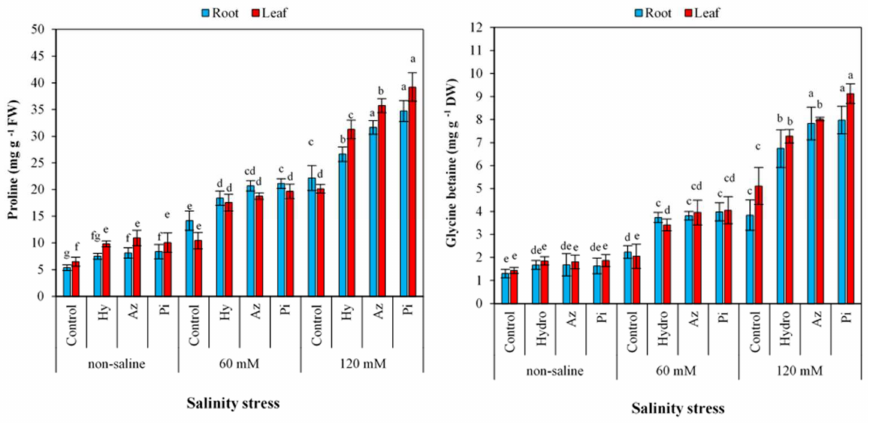
Figure 7. Effect of seed priming on proline and glycine betaine in root and leaves of milk thistle under different levels of salinity. The same letter within each column indicates no significant difference among treatments ( p ≤ 0.05) using New Duncan’s test. Values mean of four replicates ± SD. Hydro: